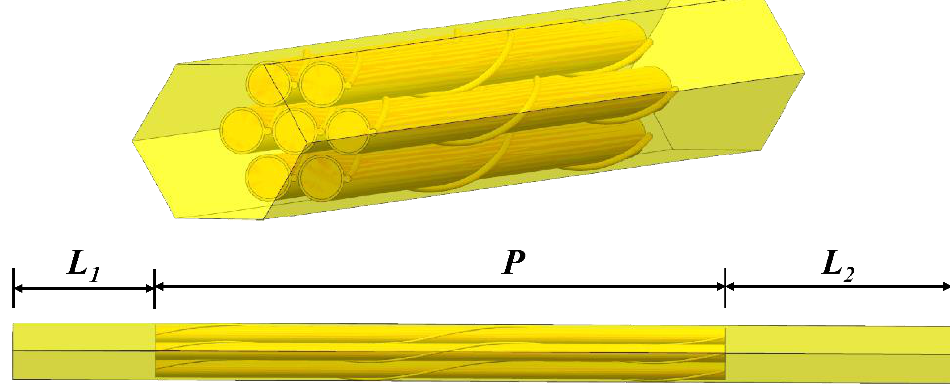
Figure 1. The calculation domain of 7-pin fuel bundle with inlet and outlet sections .